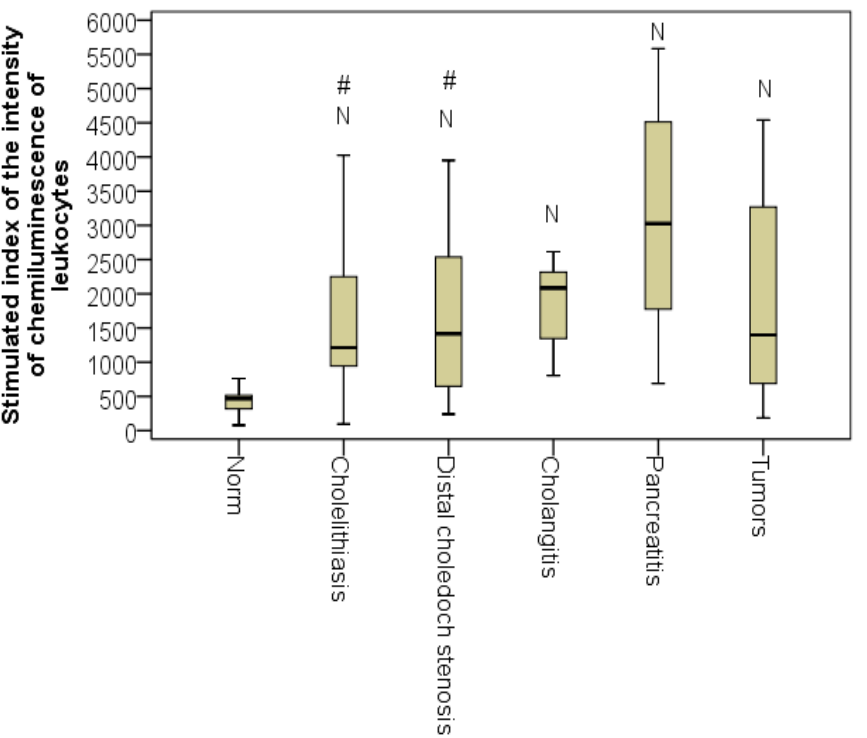
Figure 3. sCLII for different jaundice etiologies ( n = 128; p < 0.01). N, the difference from the norm at p < 0.01; # the difference from patients with acute pancreatitis at p < 0.05 (Kruskal-Wallis test).